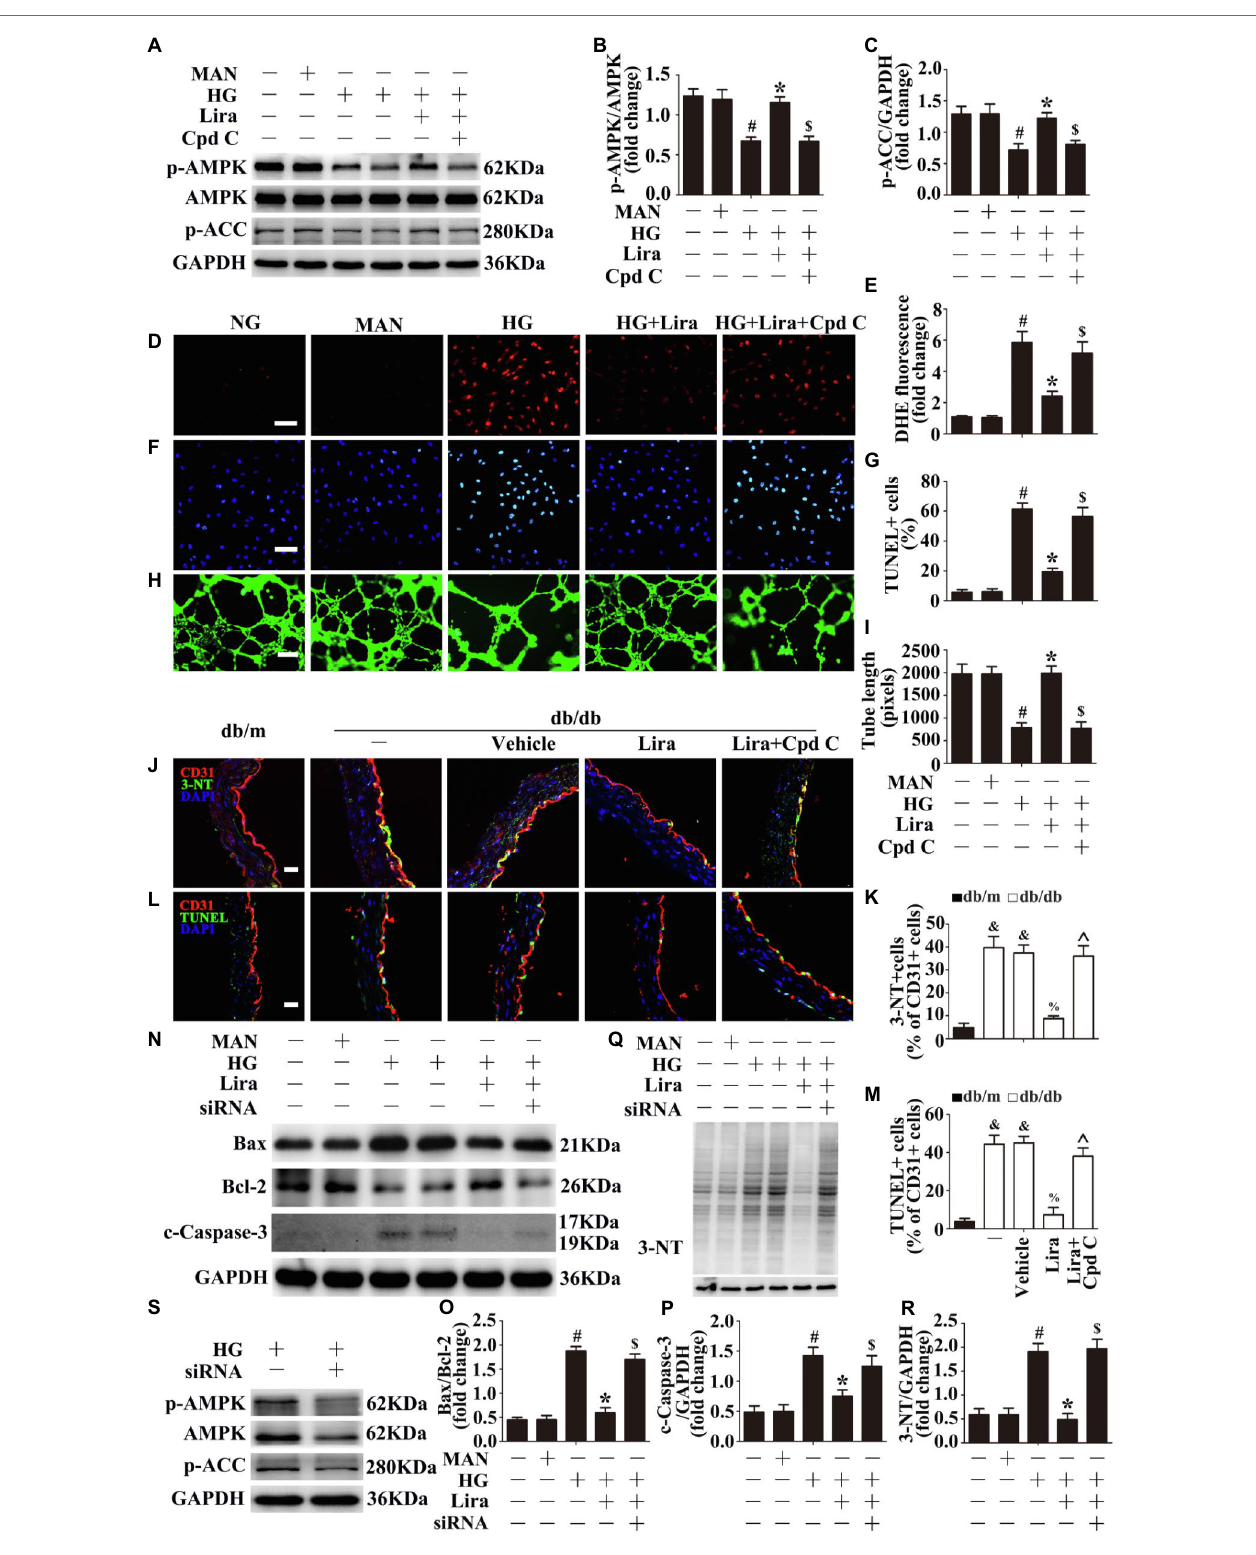
FIGURE 2 | The endothelial protective action of Lira against hyperglycemia is AMP-activated protein kinase (AMPK)-dependent. (A) Cell lysates of HUVECs were used to detect the p-AMPK and phosphorylated acetyl-CoA carboxylase (p-ACC) protein levels by immunoblotting. HUVECs were cultured either in NG or